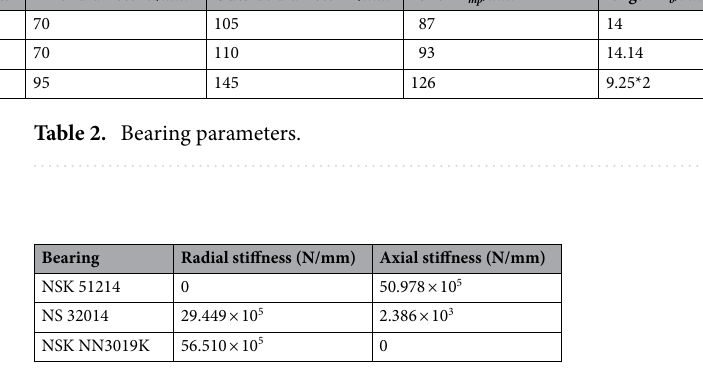
Table 3. Stiffness of the rolling bearing.